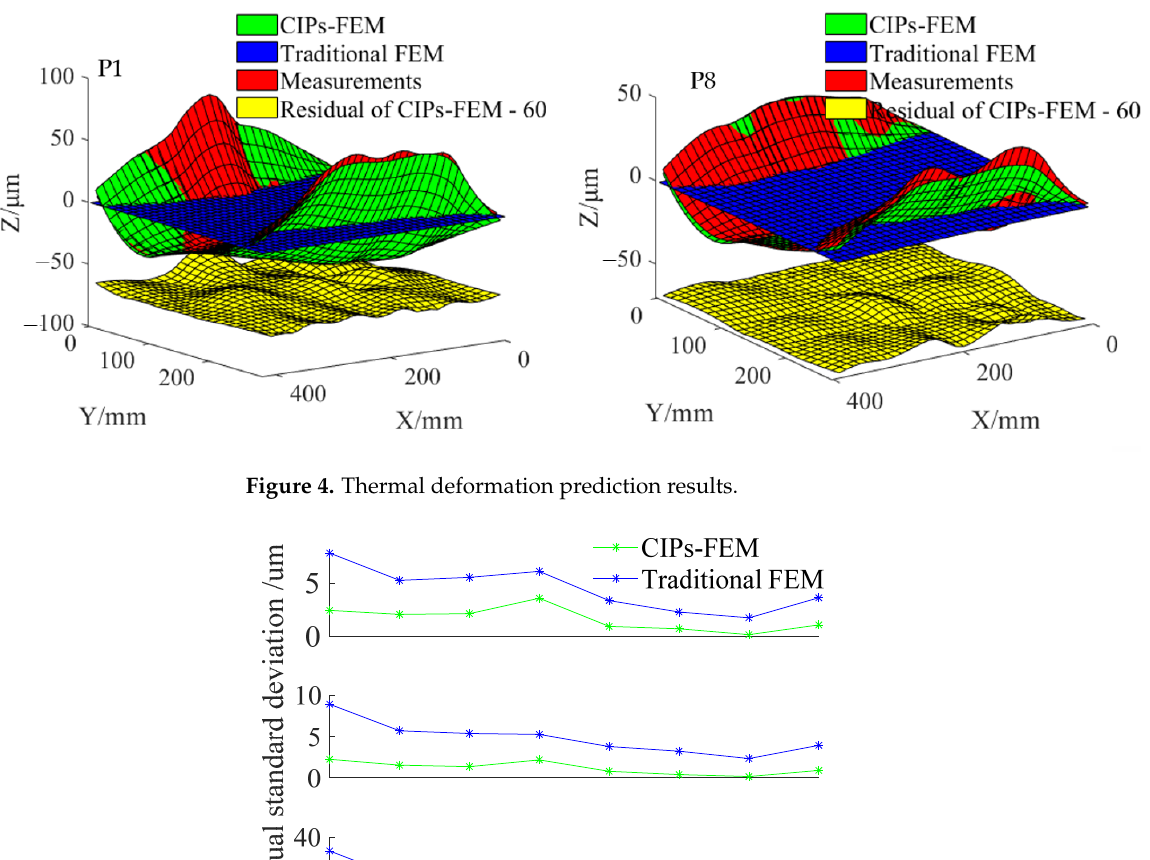
7 of 13 Table 2. Temperature measurement results. Batch